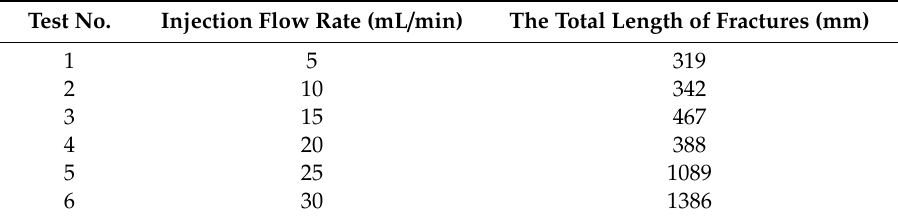
Figure 13. The fracture geometries of Tests 1 – 6: ( a ) – ( f ) are the fracture geometry photos after the rock samples were cut in half when the injection flow rate was respectively 5, 10, 15, 20, 25, and 30 mL / min, all the fractures were marked, the blue rectangles are enlarged by five times and displayed in the middle, the red rectangles are enlarged by five times, and displayed on the right side. Table 5. The Fracture Total Length.